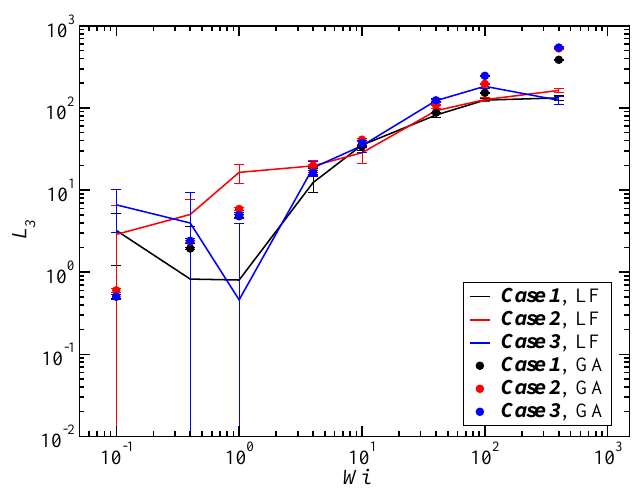
Figure 12. Comparison between the exact value of the component L 3 of the angular momentum, Equation (4), with the one obtained from the geometrical approximation, Equation (25).